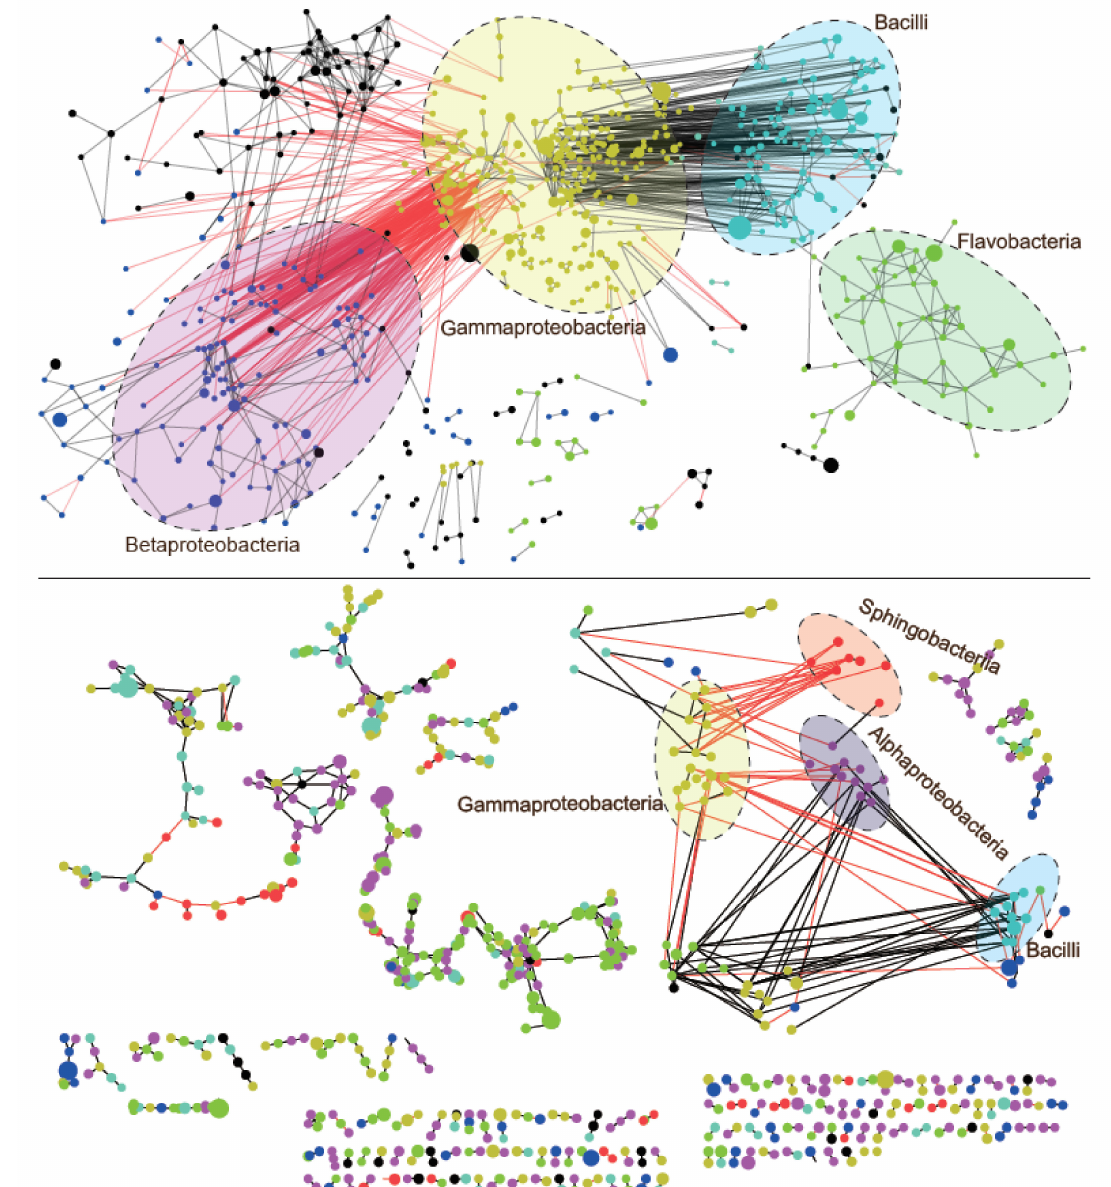
Figure 6. Co-occurrence networks of bacterial communities in melt ponds (top panel) and periglacial rivers (bottom panel). The red lines represent negative interactions while black lines represent positive interactions. The coloured nodes are labeled with their class information, while the black nodes without any taxonomic annotation belong to Others and Unclassified